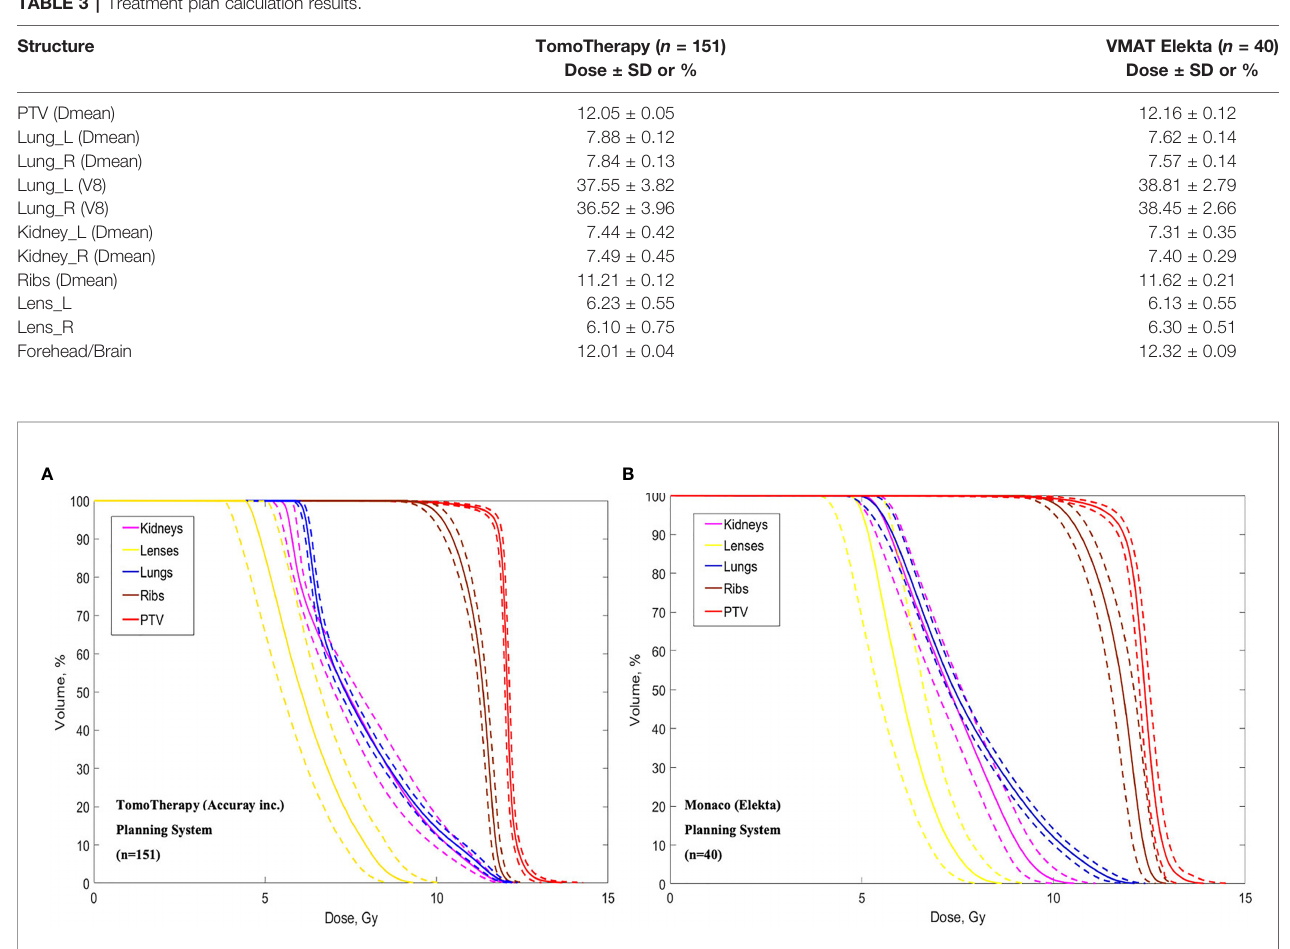
TABLE 3 | Treatment plan calculation results.